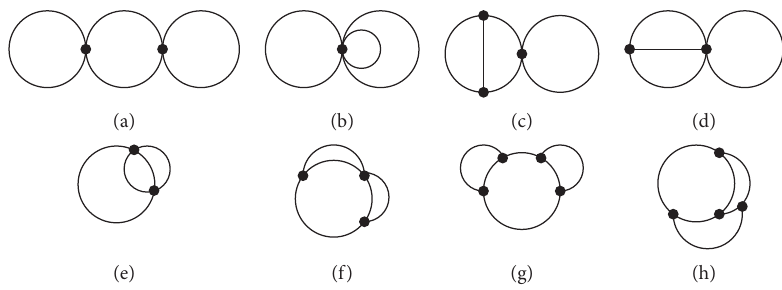
Figure 4: Eight underlying graphs of tricyclic signed graphs in case